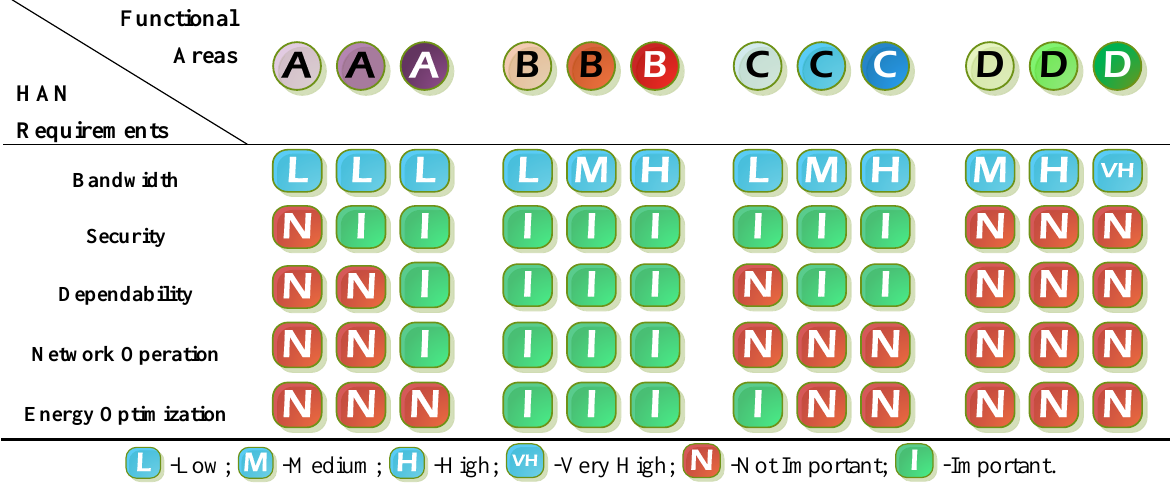
Table 4. Functional areas requirements vs . home area network (HAN) requirements. Functional